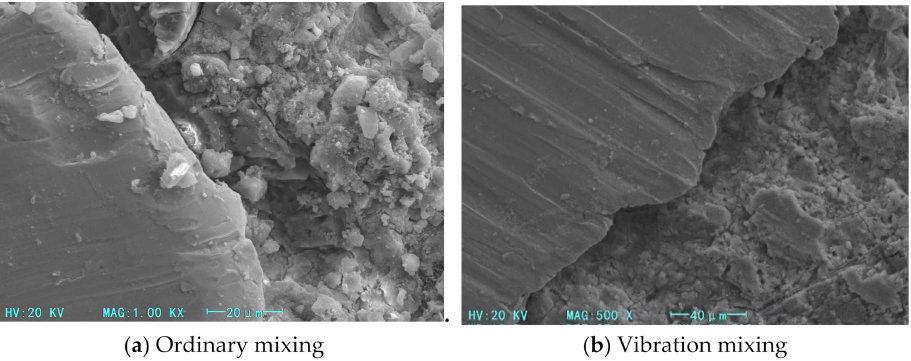
Figure 14. Microstructure of interfacial transition zone. (Magnified 500 times). ( a ) Ordinary mixing ( b ) Vibration mixing.